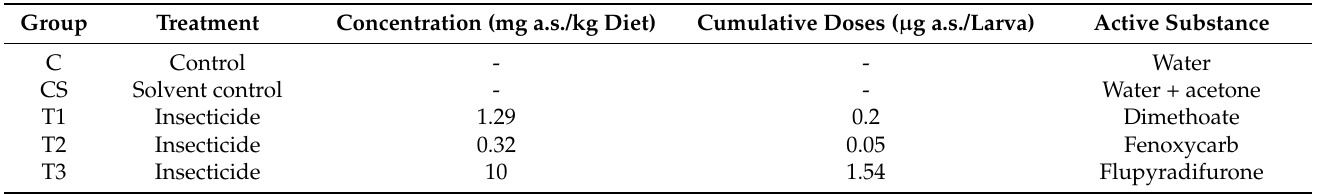
Table 1. List of sample groups, corresponding test substances and their respective concentrations and cumulative